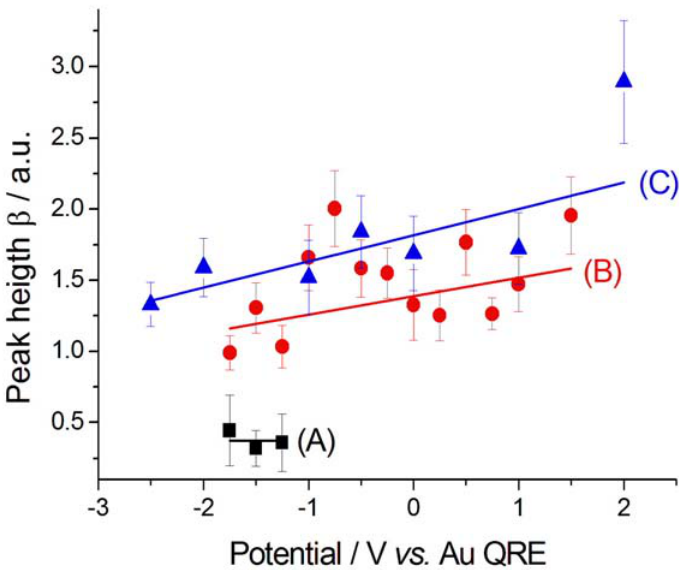
Figure 9. Peak height  corresponding to CN − adsorbed at Au in contact with [BMP][TFSA] containing 1 mM CTDB without ( A , B ) and with ( C ) 25 mM K[Au(CN) ( A ) Cathodic-going scan, SFG spectra (see Figure 2); ( B ) Anodic-going scan, DFG spectra (see Figure 3); ( C ) Anodic-going scan, DFG spectra (see Figure 4). The error bars correspond to estimated 95% confidence intervals.